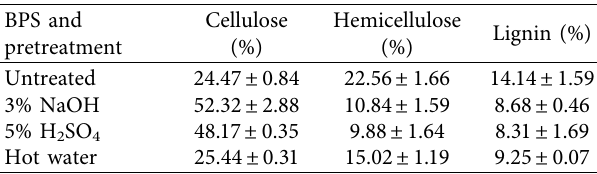
Table 1: Chemical composition of the untreated and pretreated banana